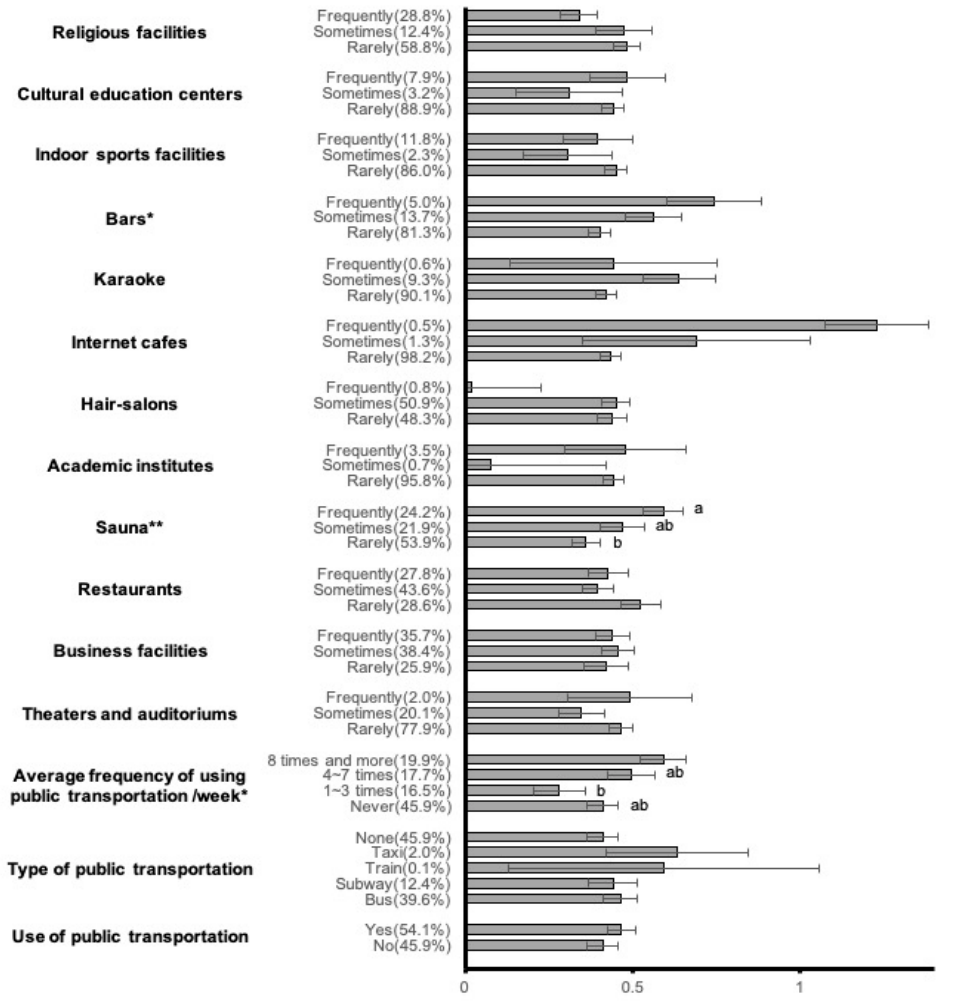
Figure 2. Means and standard errors of log-transformed urinary cotinine concentrations according to